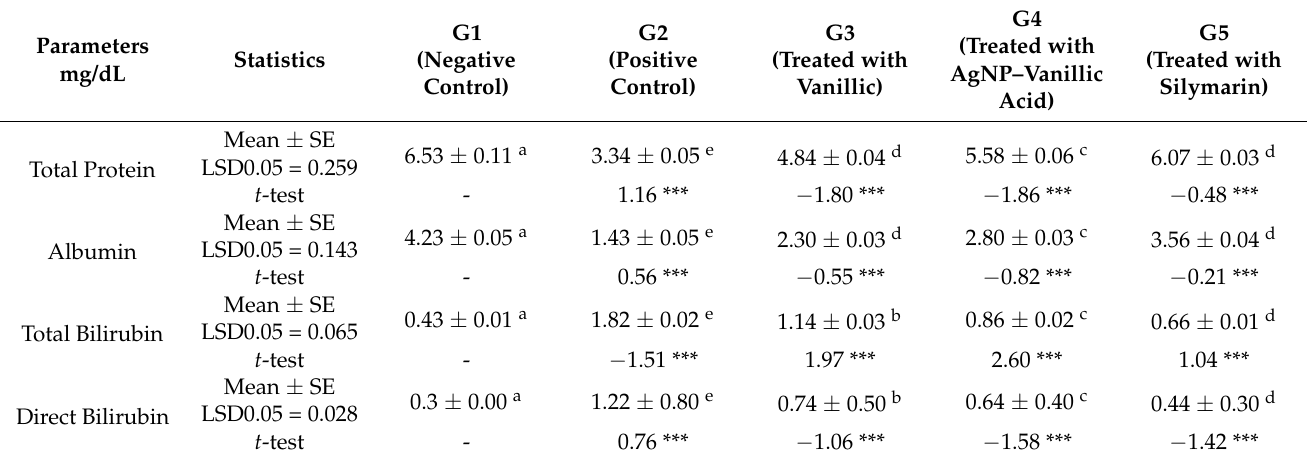
Table 1. The effects of vanillic acid-loaded silver nanoparticles on serum protein and bilirubin in CCl 4 liver toxicity-induced